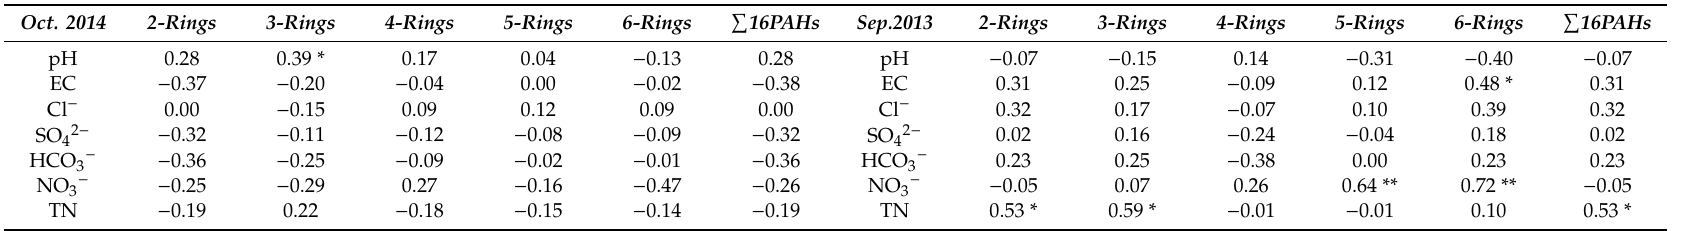
Table 4. Pearson correlation coe ffi cient of PAHs compositions with physic-chemical parameter and ionic concentrations in